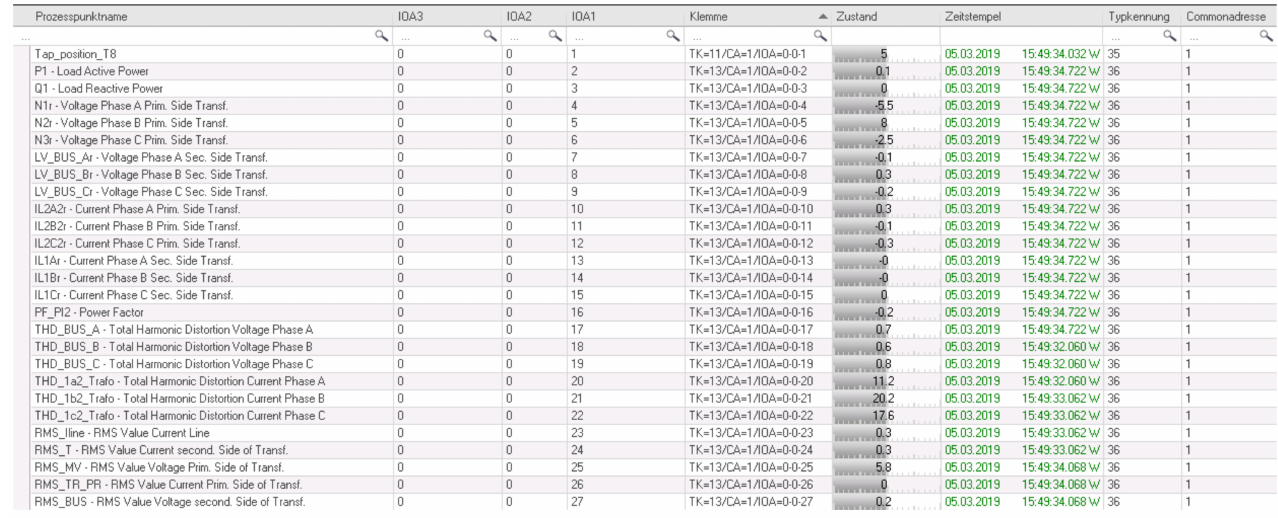
Figure 8. The received measured data from the